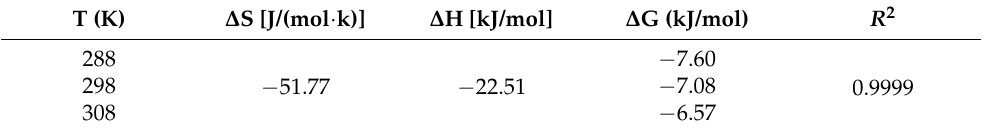
Table 4. Thermodynamic parameters for the adsorption of SL by 2.8%CB-LDH.